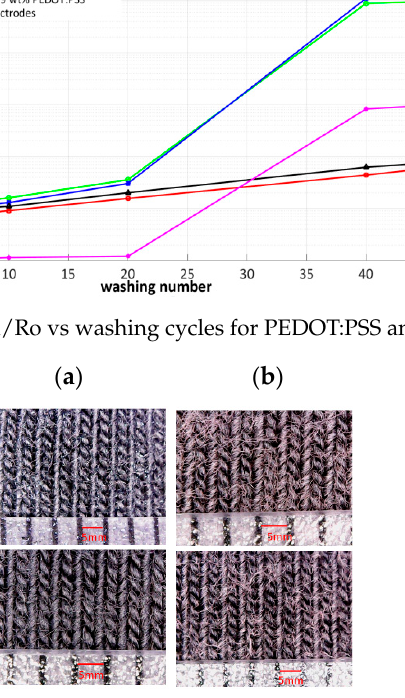
Figure 6. Surface morphology of cotton/lycra electrodes: ( a ) before washing: 6.3 wt.% PEDOT:PSS; ( b )